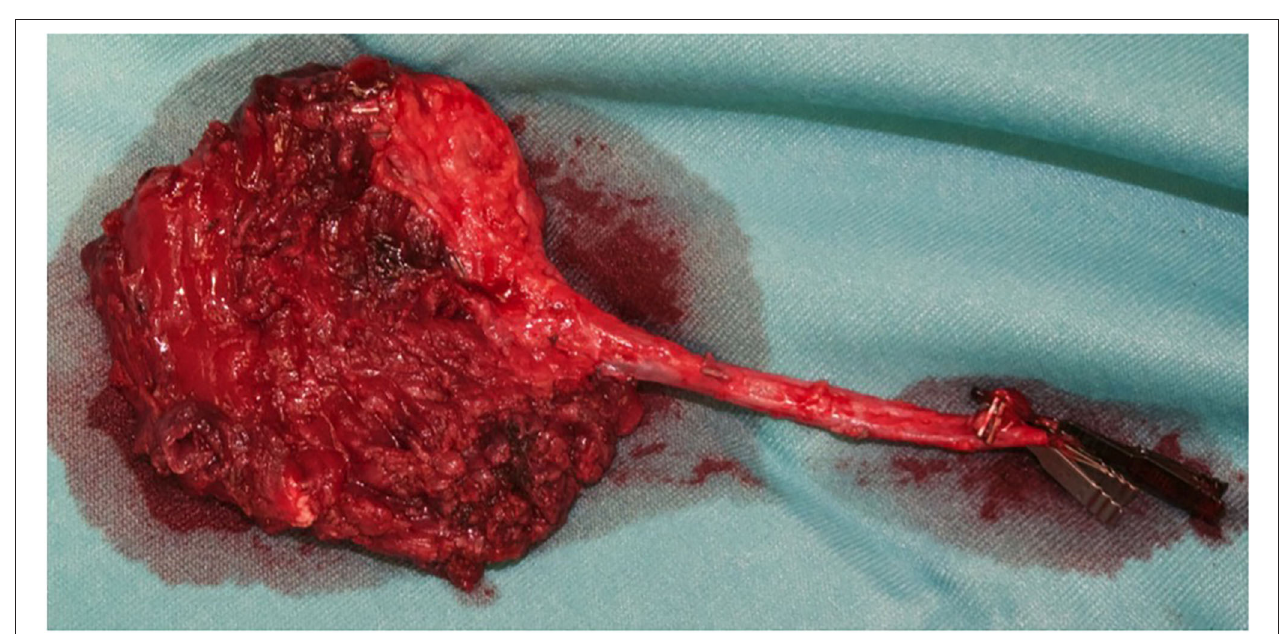
FIGURE 4 | The free vastus lateralis flap harvested through a muscle sparing